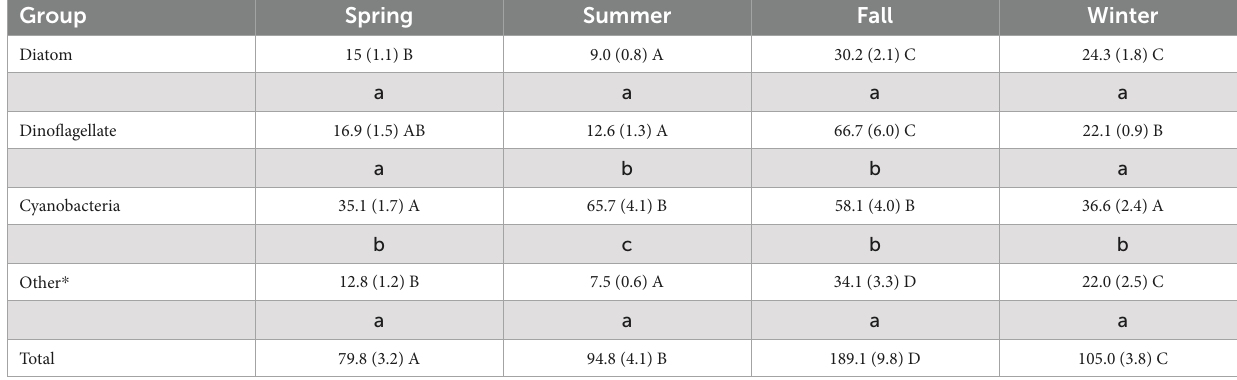
Results of Games-Howell post-hoc pairwise comparison of means are shown with capital letters comparing the functional group across different seasons (horizontally) and lower-case letters comparing different functional groups in a single season (vertically). Mean values which share letter designations are not significantly different ( p of